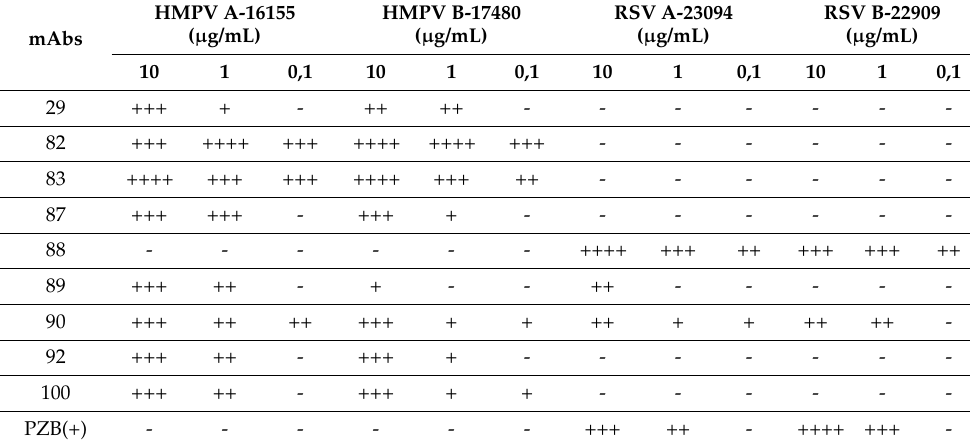
Table 1. In vitro neutralization of HMPV and HRSV strains by monoclonal antibodies. The neutral- ization capacity of selected monoclonal antibodies against HMPV and RSV was evaluated using microneutralization assays. Each antibody was tested at 10, 1 and 0.1 µ g/mL against two separate strains of HMPV as well as two strains of RSV. -, +, ++, +++, ++++ indicate 0, 25, 50, 75 and 100% plaque reduction, respectively. Palivizumab [PZB(+)] was used as positive control against RSV. HMPV A-16155 ( µ mAbs